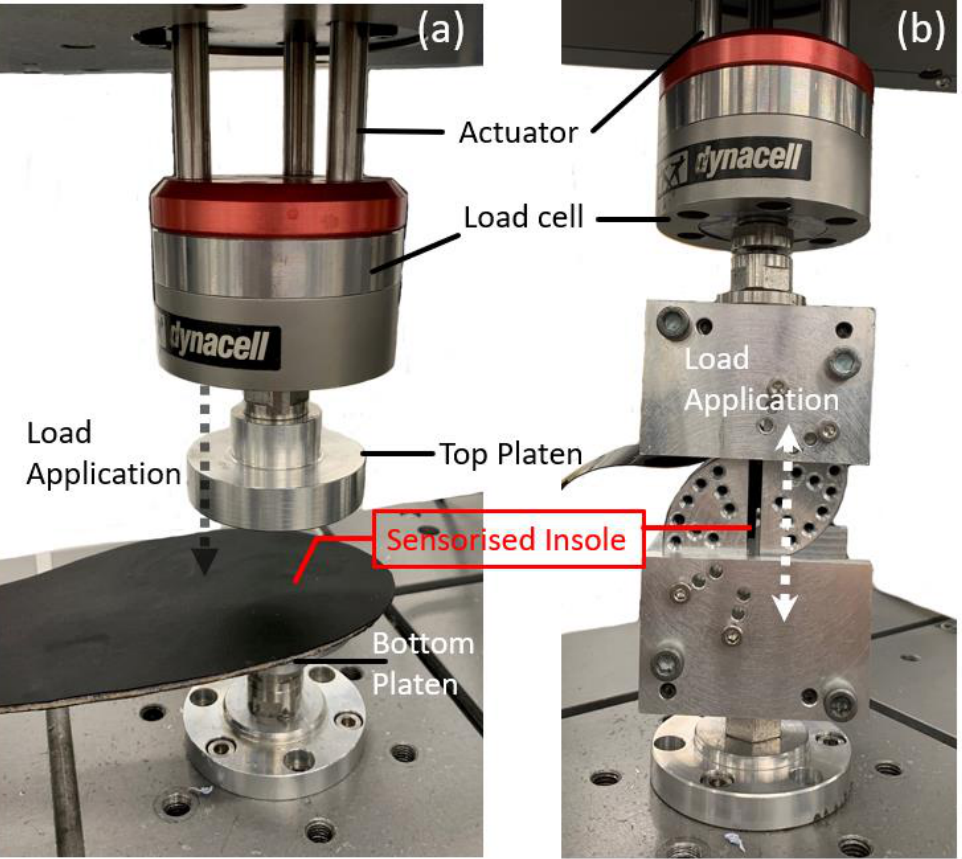
Figure 3. Experimental setup for evaluating ( a ) pressure and ( b ) shear stress measurement from the insole system.